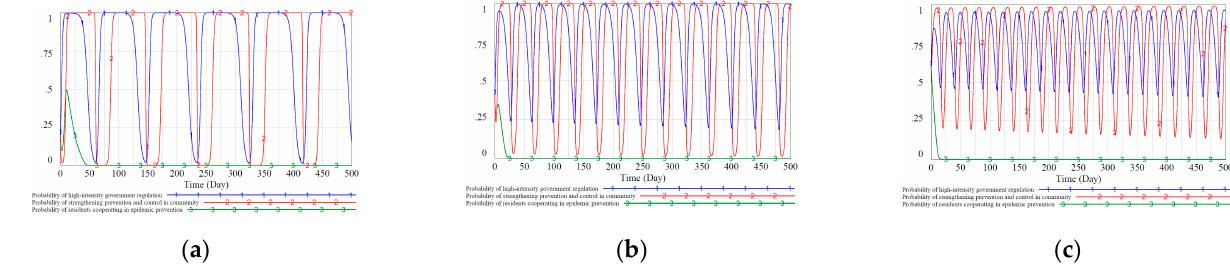
Figure 4. The impact of different initial strategy combinations on the evolutionary stable equilibrium strategy under the static reward and punishment mechanism. ( a ): initial value strategy combinations ( x 0 = 0.2, y 0 = 0.2, z 0 = 0.2 ) . ( b ): initial value strategy combinations ( x 0 = 0.4, y 0 = 0.4, z 0 = 0.4 ) . ( c ): initial value strategy combinations ( x 0 = 0.6, y 0 = 0.6, z 0 = 0.6 )